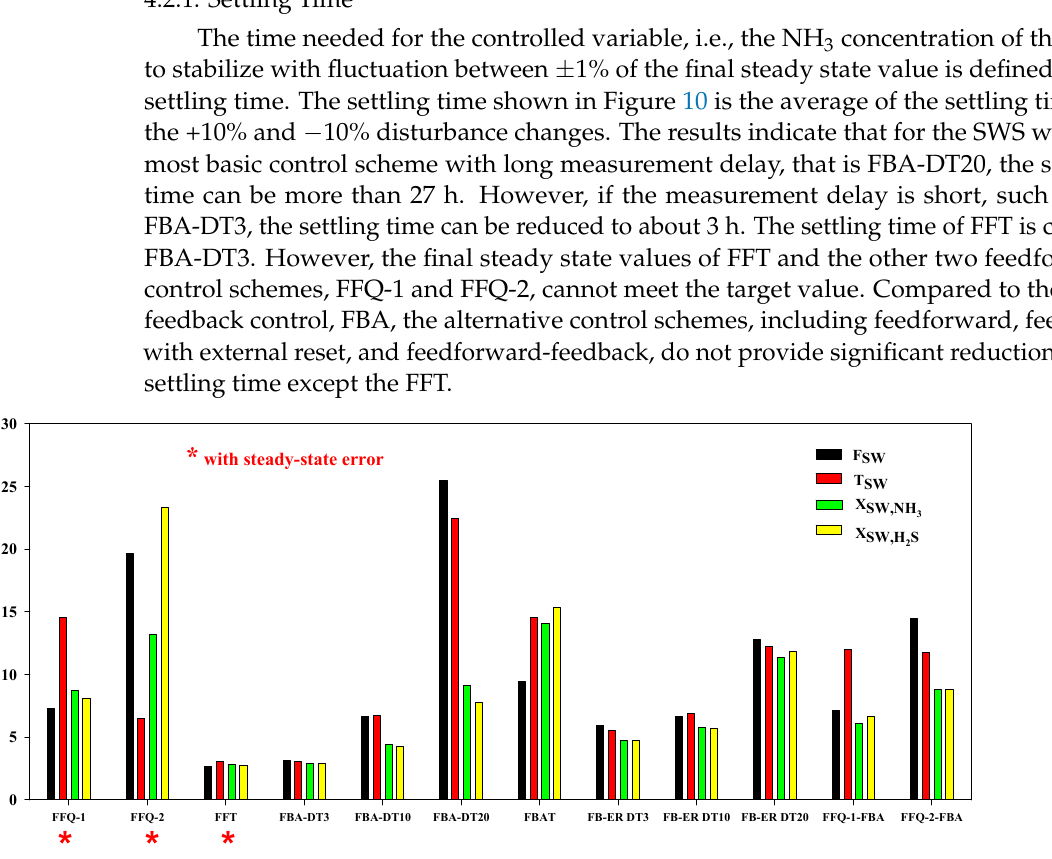
Figure 10. Settling time results of all control schemes for the sour water feed stream disturbances, including flowrate, temperature, NH 3 concentration, and H 2 S concentration. (* with steady state offset).